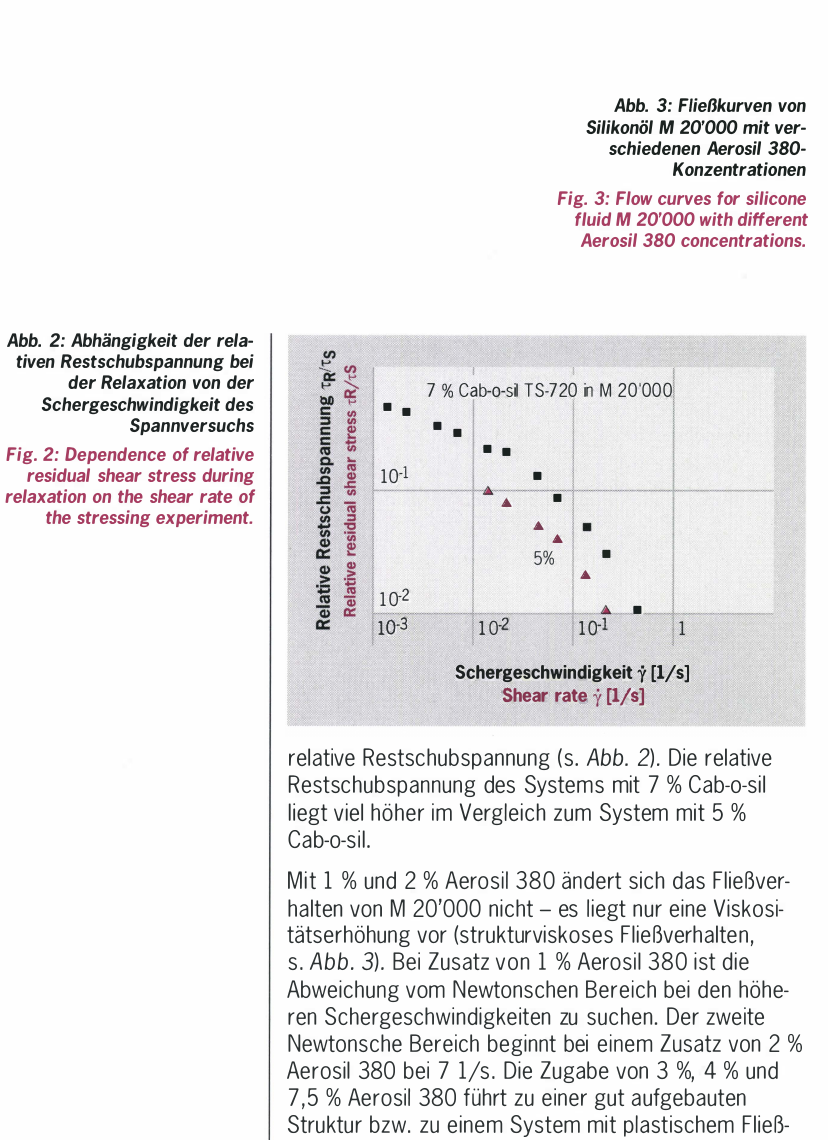
Fig. 3: Flow curves for silicone fluid M 20'000 with different Aerosil 380